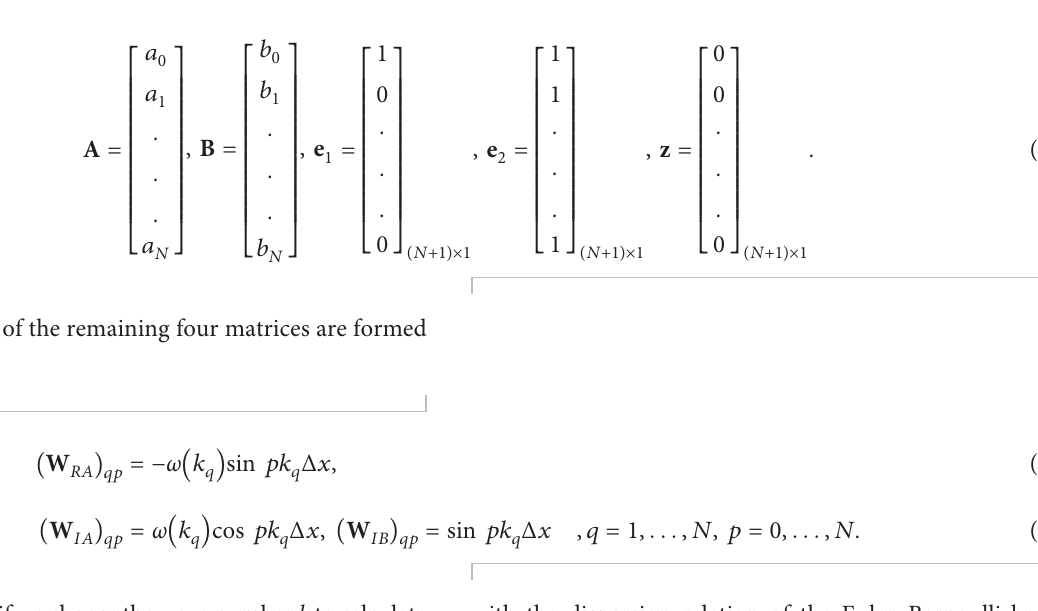
Figure 2: Boundary condition design diagram: (a) schematic diagram of the surface layer boundary condition; (b) schematic diagram of the internal layer boundary condition at the left